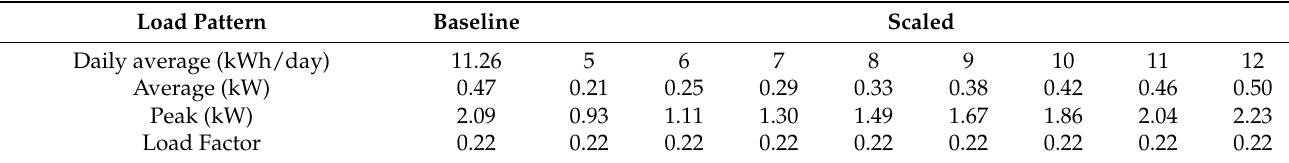
Table 4. Scaled standard load